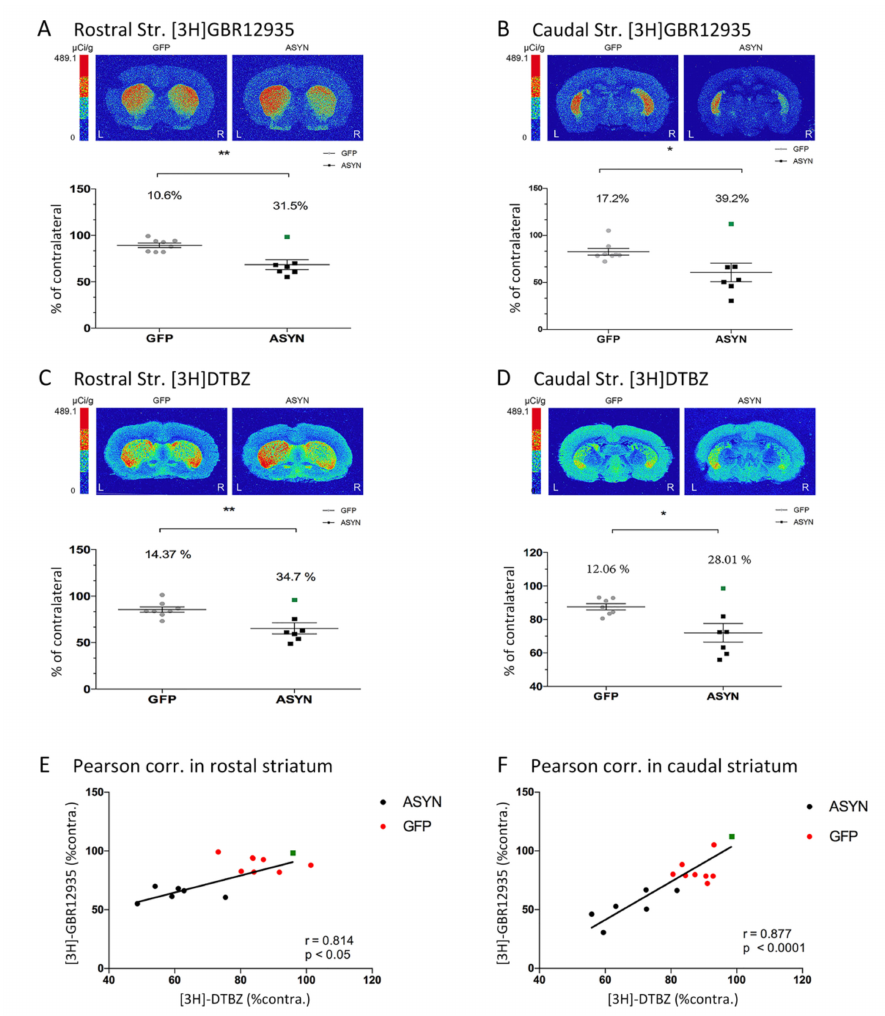
Figure 4. Representative autoradiograms of [ 3 H]GBR12935 binding to DAT in the ( A ) rostral and ( B ) caudal striatum and of [ 3 H]DTBZ binding to VMAT2 in the ( C ) rostral and ( D ) caudal striatum. Graphs in each panel show the ipsilateral value as percentage of the contralateral binding. The green square represents the animal with lateral ASYN expression in the striatum. GFP ( n = 8), ASYN ( n = 7). The percentage shows the % decrease in ipsilateral binding, compared to contralateral binding. Data are mean ± SEM, * p < 0.05, ** p < 0.01 (unpaired t-tests with Welch’s correction). Distance from bregma 0.48 mm, − 1.80 mm, − 0.26 mm, and − 0.92 mm, in ( A – D ), respectively. Pearson correlations, with r and p value indicated, of DAT and VMAT2 are presented in ( E ) the rostral, and ( F ) the caudal level of the